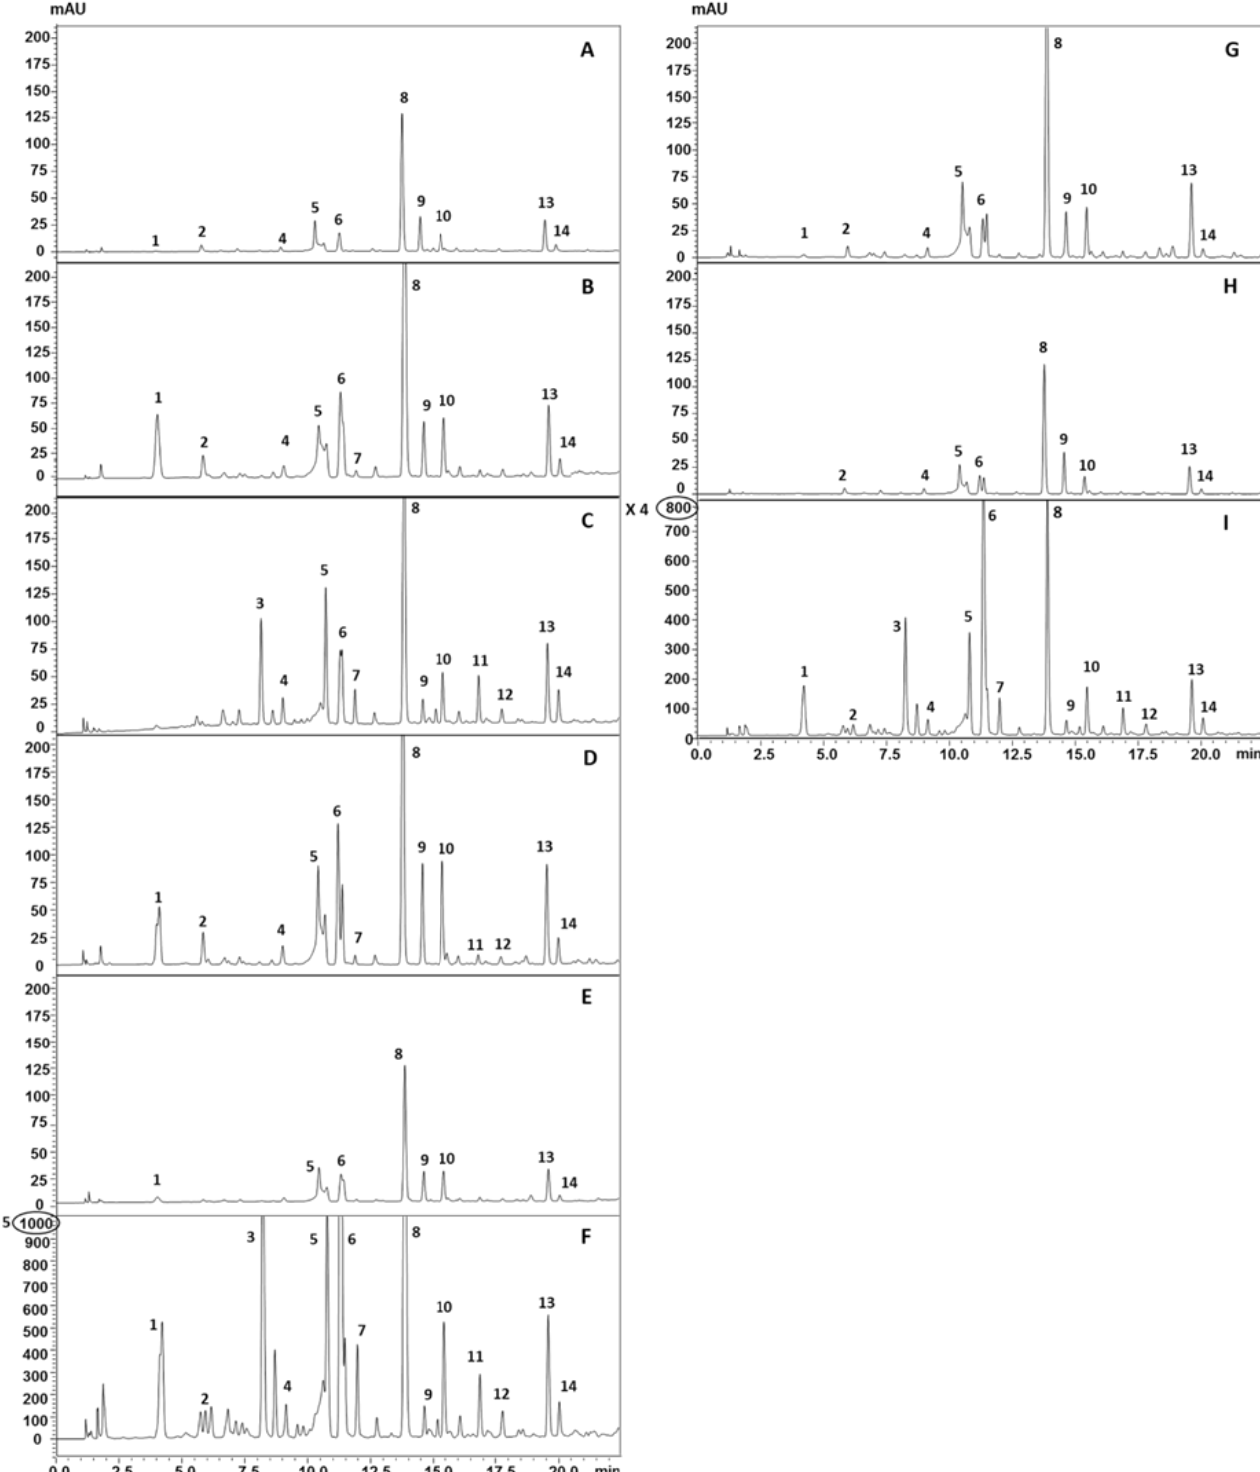
Figure 2. HPLC-PDA chromatograms of phenolic compounds in YV1 ( A – C ), YV2 ( D – F ), and I/S ( G